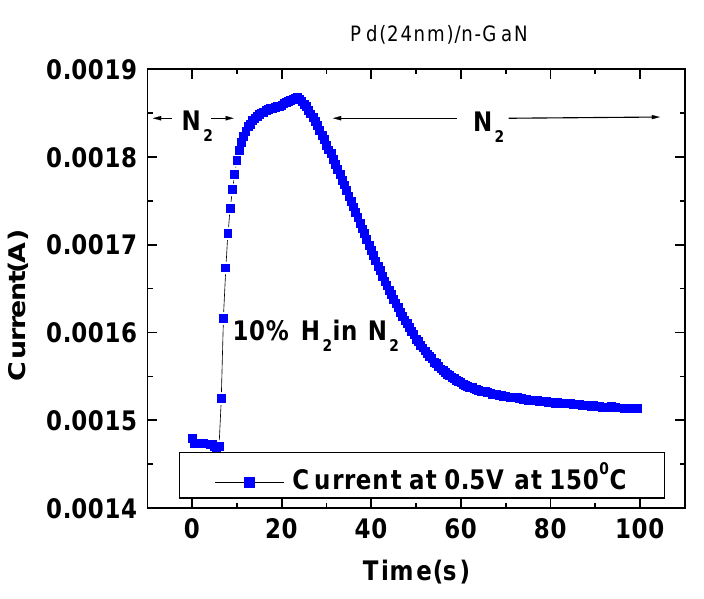
Figure 8. Forward current of Pd/GaN Schottky diode at fixed bias of 0.5V and a temperature of